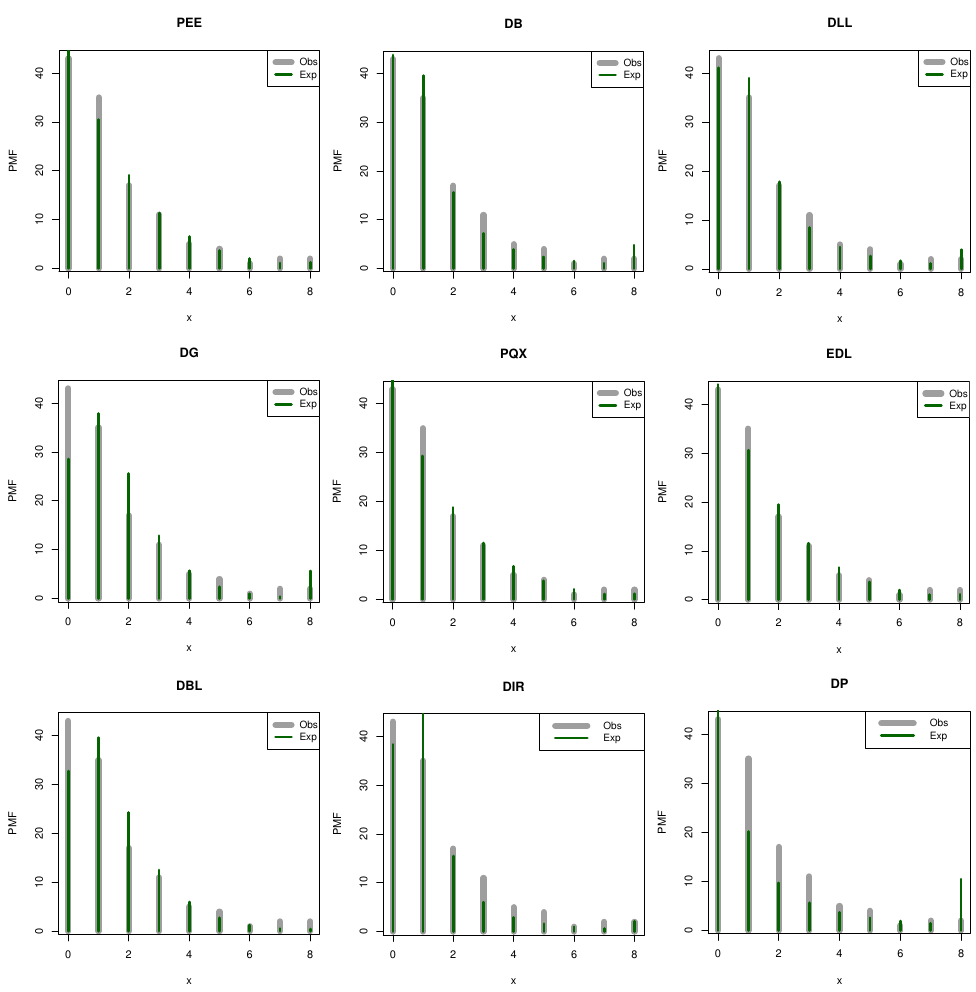
Figure 2. Pmfs of fitted models for corn borer